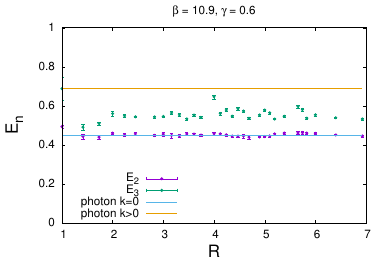
Figure 3 is a log plot of T nn ( R , T ) vs. T at R = 5 . 83, γ = 0 . 6, for n = 1 , 2 , 3, on a 12 3 × 36 lattice. From the slopes, we deduce that E 1 = 0 , E 2 = 0 . 46 , E 3 = 0 . 55 in lattice units.